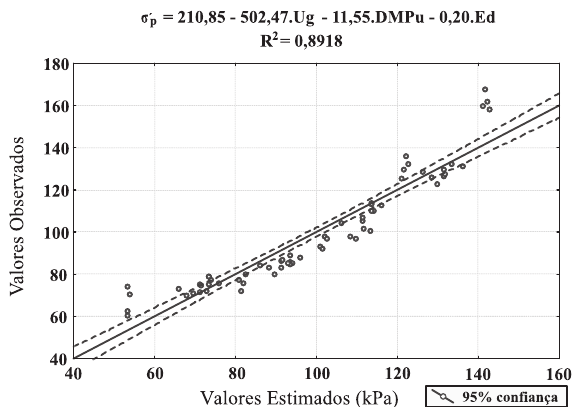
figura 5. modelo de tensão de pré-compactação ( s ´ p ) em função da umidade gravimétrica (ug), do diâmetro médio ponderado dos agregados via úmida (dmpu) e da quantidade de energia dissipada (ed). Valores estimados contra valo- res observados, na profundidade de 0–0,20 m.